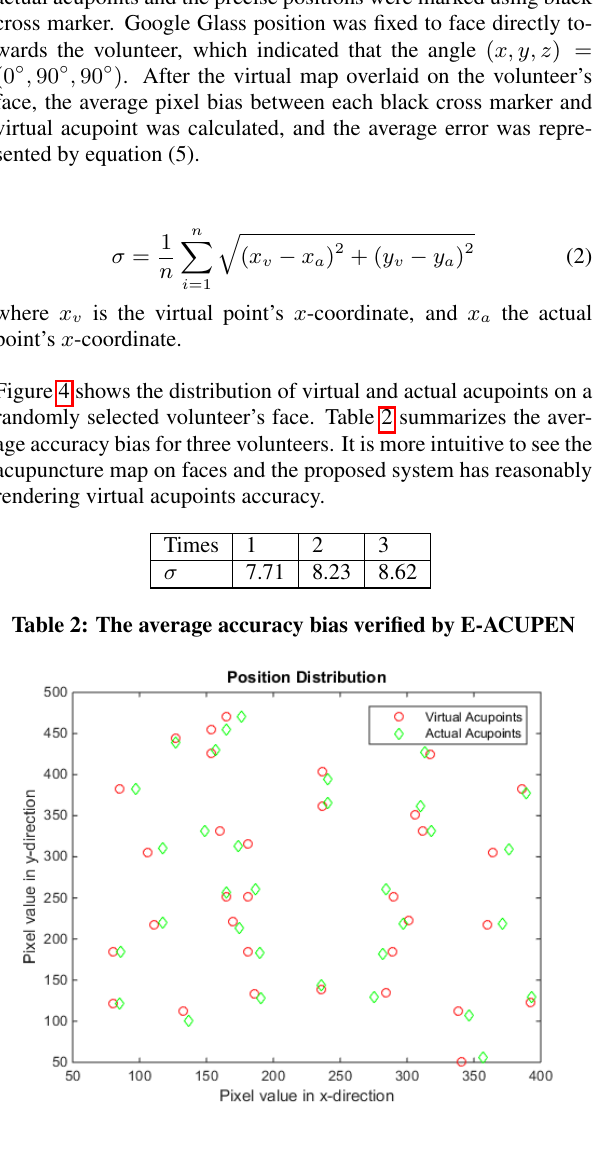
Figure 4: Position distribution from one of the